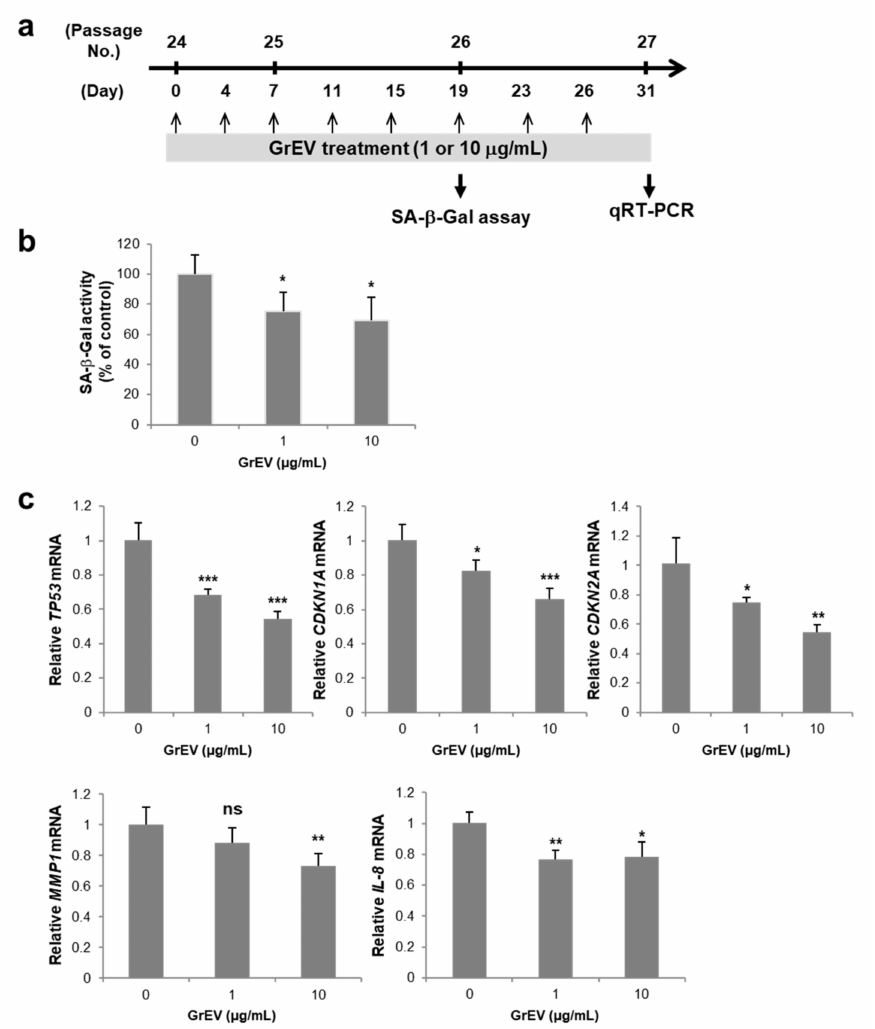
Figure 2. Ginseng root-derived extracellular vesicles (GrEVs) caused an anti-senescence effect in replicative senescent human dermal fibroblasts (HDFs). ( a ) Scheme used to treat replicative senescent HDFs with GrEVs. HDFs (2 × 10 5 ), which were not treated (0 µ g/mL; HEPES-buffered saline (HBS) buffer-treated) or were repeatedly treated with GrEVs at different doses (1 or 10 µ g/mL) every third or fourth day, were harvested at passage numbers 26 and 27 (after > 50 population doublings). ( b , c ) The harvested cells were analyzed for senescence-associated beta-galactosidase (SA β -Gal) activity using a Mammalian β -Gal Assay Kit ( b ) and for gene expression by performing reverse transcriptase-quantitative polymerase chain reaction experiments using specific primers ( c ). SA β -Gal activity and gene expression levels were normalized to protein quantities and RPL13A expression, respectively. The data (in b and c) represent the means ± standard deviations of three independent experiments, using two independent senescent cell lines from one donor (* p < 0.05, ** p < 0.01, *** p < 0.001; ns,